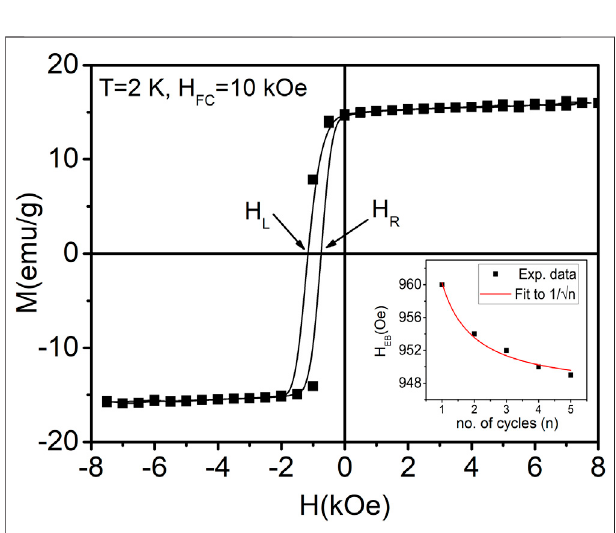
FIGURE 7 | EB effect: Magnetic hysteresis (M-H) loop measured at 2 K after fi eld cooling process in presence of 10 kOe magnetic fi eld. Inset shows thetrainingeffectofexchangebiasobservedinthepresentribbons.Heresolid squaresshowtheexperimentaldataandsolidlineshowsthe fi ttosimple power law (H EB − H EB ∞ α 1/ √